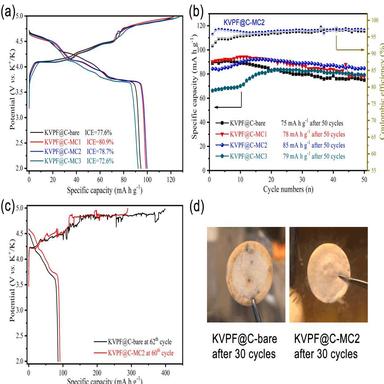
Electrochemical properties of KVPO4F-based half-cells: (a) 1st charge–discharge curves at 0.2C; (b) Cycling performance at 0.5C; (c) Selected charge–discharge curves at 0.5C; (d) Digital photos of the separators after 30 cycles.